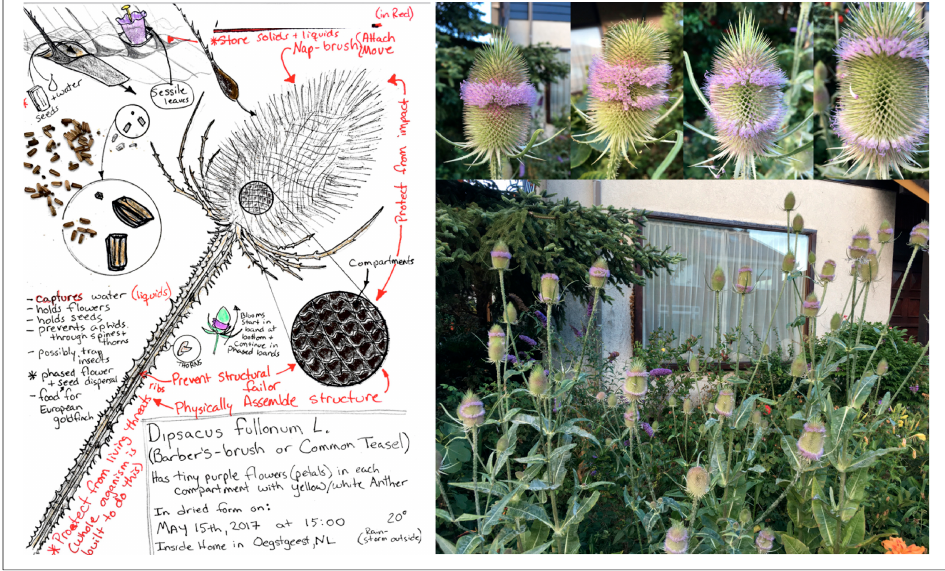
Figure 4. Example slide of LP in biology THUAS. Available online: https://www.nrcresearchpress.com/doi/pdfplus/10.4141/cjps75-122 (accessed on 26 January 2022).